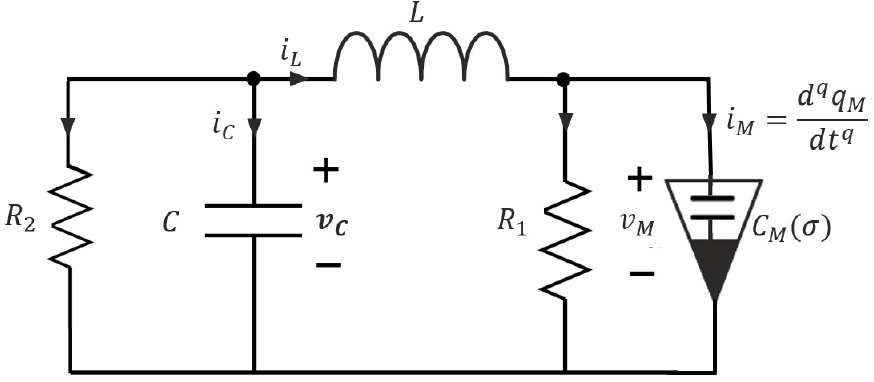
Figure 7. Fractional-order memcapacitive chaotic circuit.